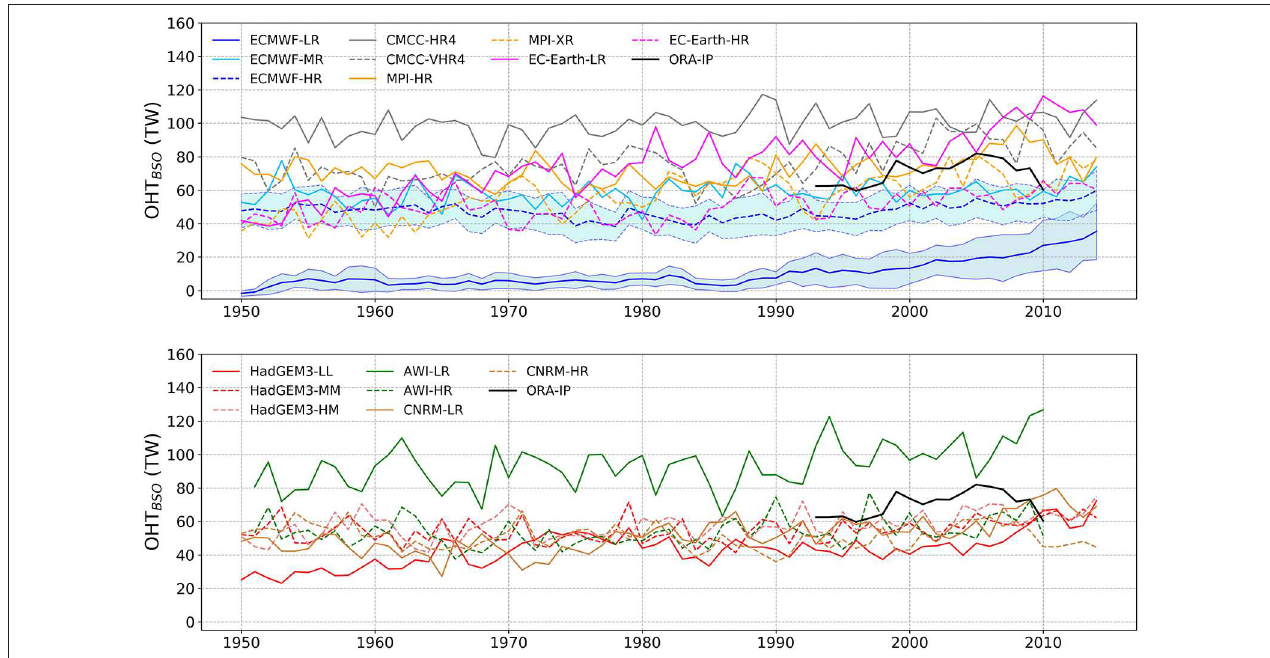
FIGURE 5 | Time series of annual mean ocean heat transport (OHT) at the Barents Sea Opening (BSO, large transect, 20 ◦ E, 70–74.5 ◦ N) over 1950–2014 using HighResMIP hist-1950 model outputs (split in two different panels for readability) and ORA-IP reanalyses. The blue shadings of ECMWF-LR and ECMWF-HR represent the ensemble standard deviation (six members for each).